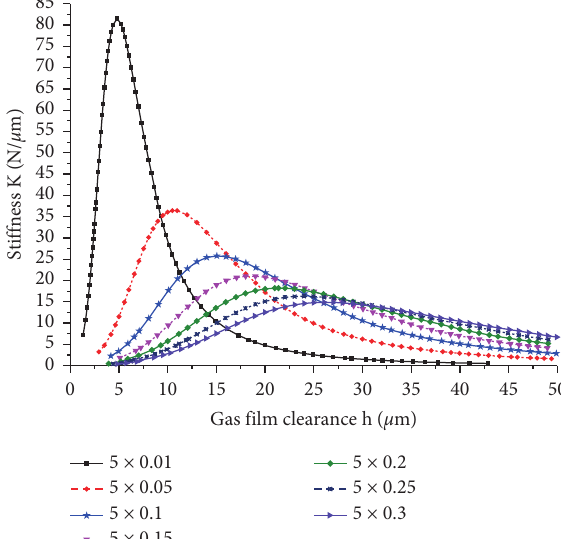
Figure 9: Curve of influence of the diameters d of the orifices on the bearing